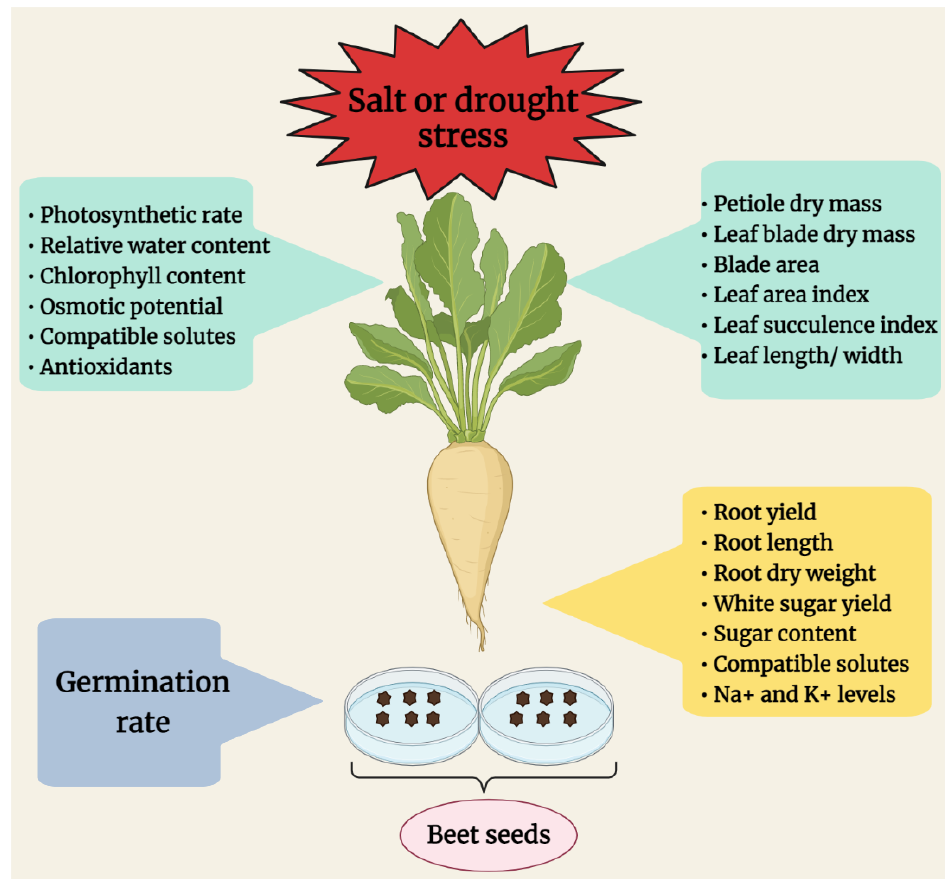
Figure 1. A brief summary of morpho-physiological and biochemical traits used to select salt-tolerant and drought-tolerant beets under high salinity and drought stresses. This figure was created by author in BioRender.com (12 July 2021).